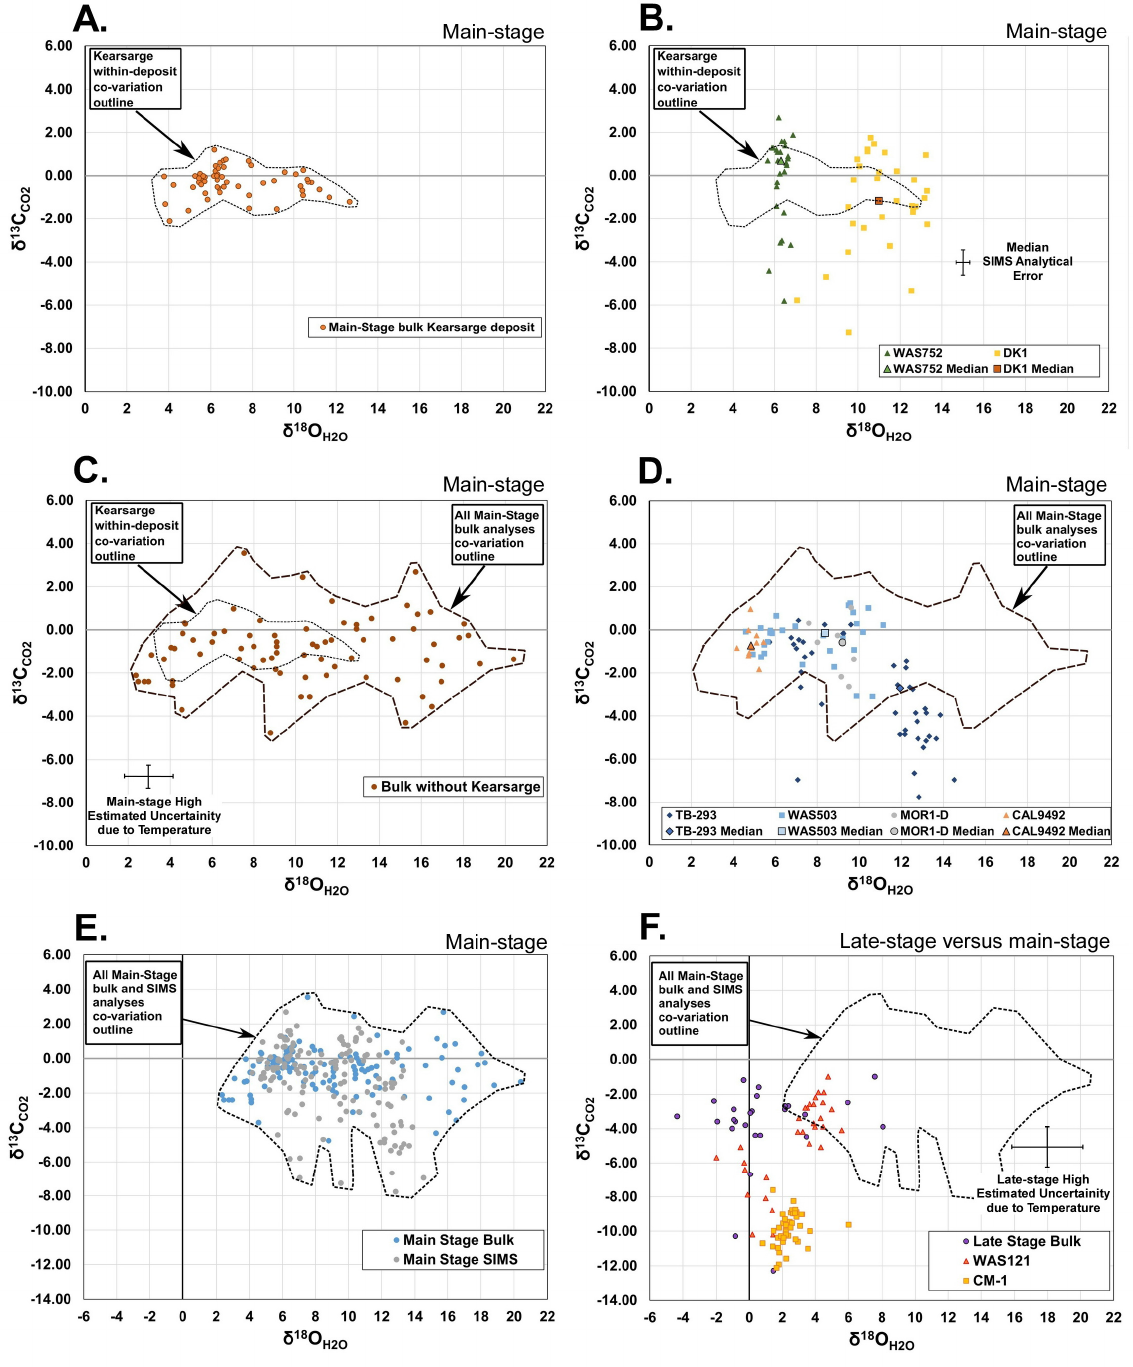
Figure 5. Covariation of carbon and oxygen isotopes in calcite from the Keweenaw Peninsula native copper district. Carbon and oxygen isotopes calculated in terms of CO 2 and H 2 O, respectively, as discussed in the text. Analytical and temperature uncertainty shown. ( A ) Main-stage Kearsarge bulk isotopic composition with field around points. ( B ) Main-stage Kearsarge bulk isotopic field compared to SIMS data with high within sample variation but median value within the bulk field. ( C ) Main- stage comparison of Kearsarge bulk isotopic composition and all bulk isotopic data. ( D ) Main-stage comparison of all bulk isotopic data to SIMS data except Kearsarge. ( E ) Main-stage all bulk and SIMS isotopic data. ( F ) Comparison of main-stage to late-stage isotopic composition. Analytical and temperature uncertainty discussed in Section